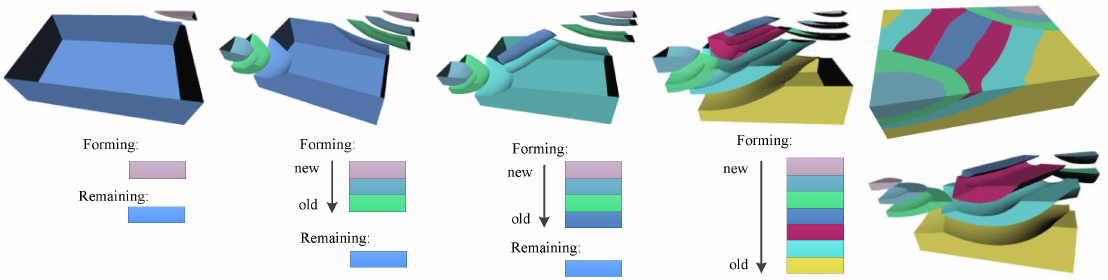
Figure 5. Sequential extraction of geological models from the fundamental body from new to